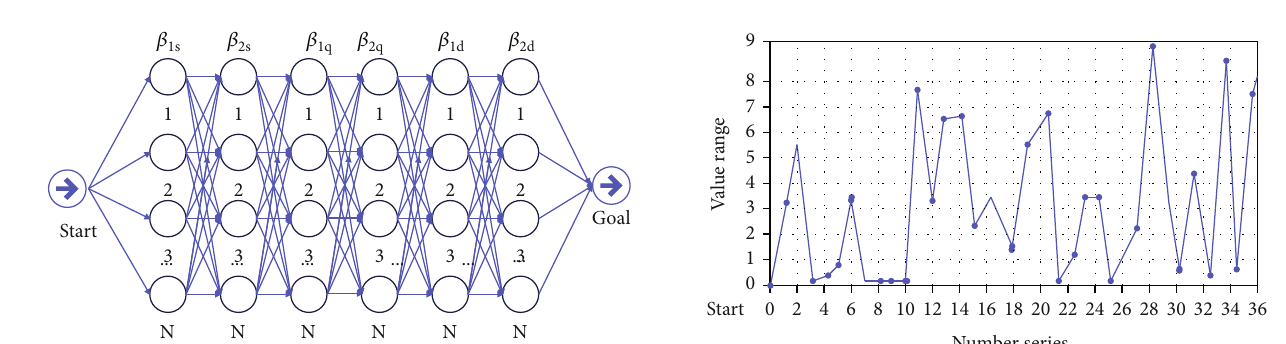
Figure 7: Structure diagram of ADRC control of induction motor based on ant colony algorithm.